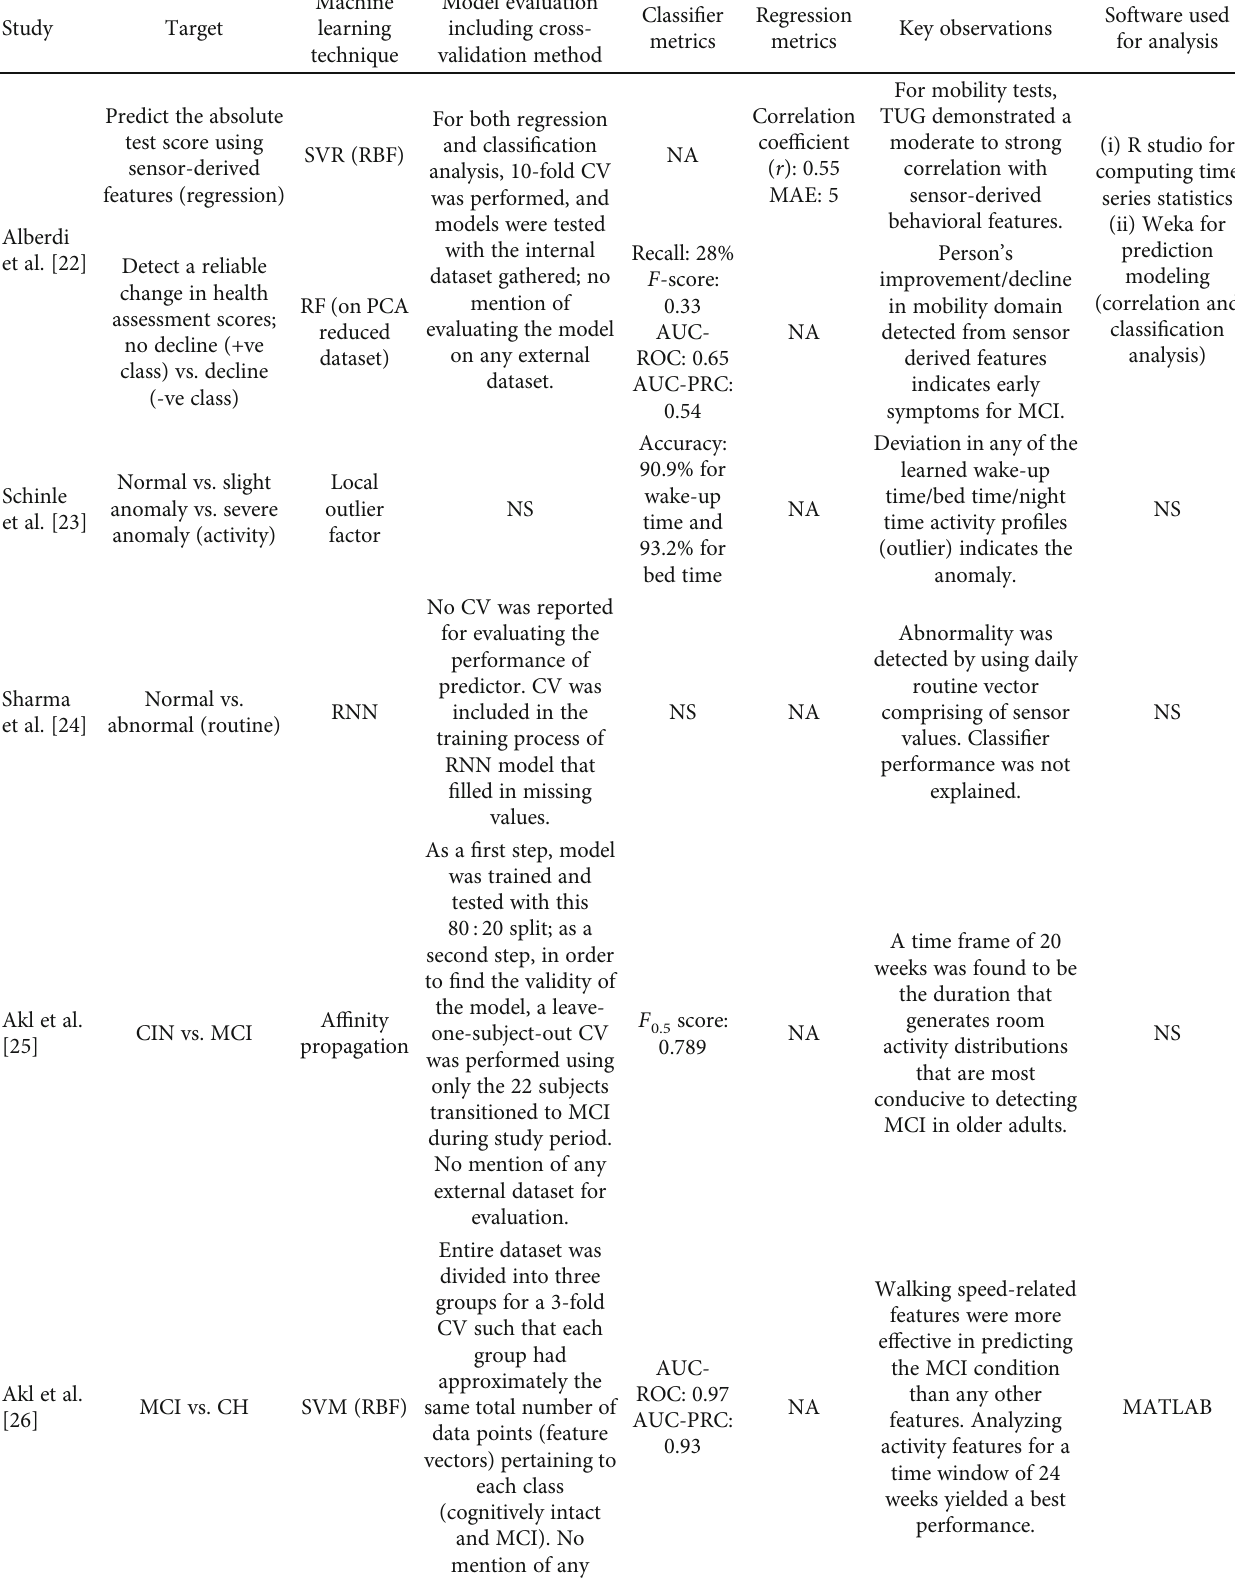
Table 4: Summary of performance metrics corresponding to best performed machine learning technique reported in each